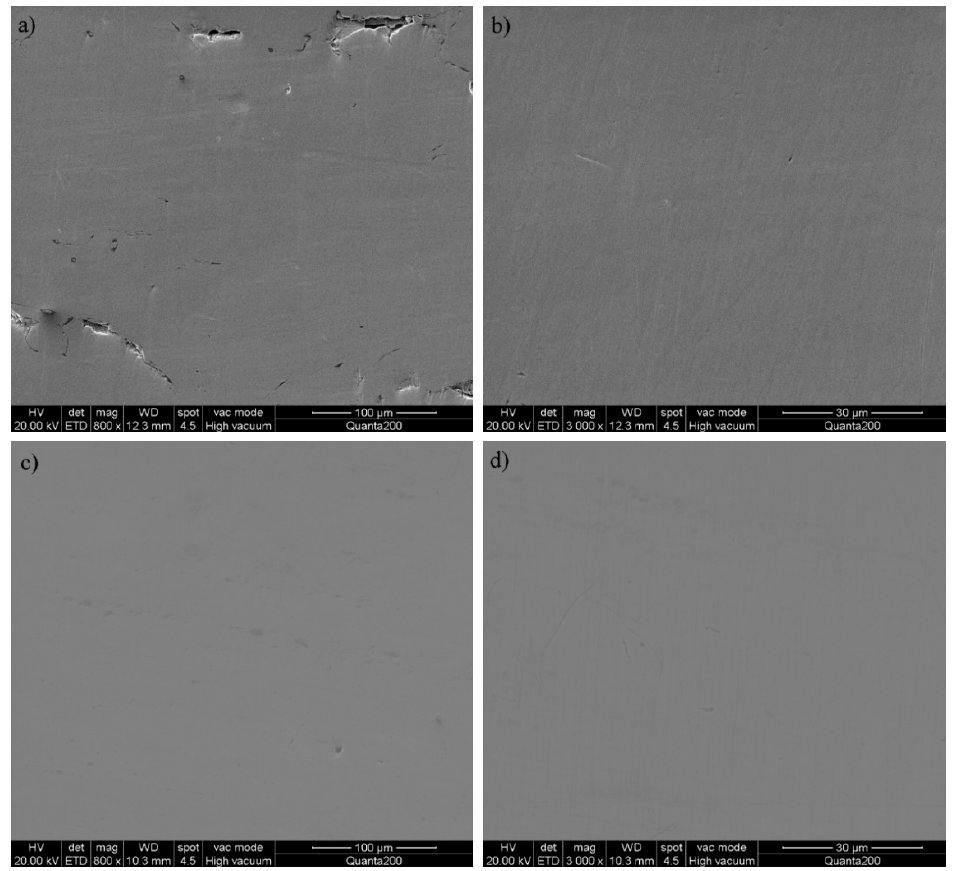
Figure 1. Surface morphologies of substrate specimens: ( a ) No. 1 at 800 magnification, ( b ) No. 1 at 3000 magnification, ( c ) No. 9 at 800 magnification, ( d ) No. 9 at 3000 magnification.